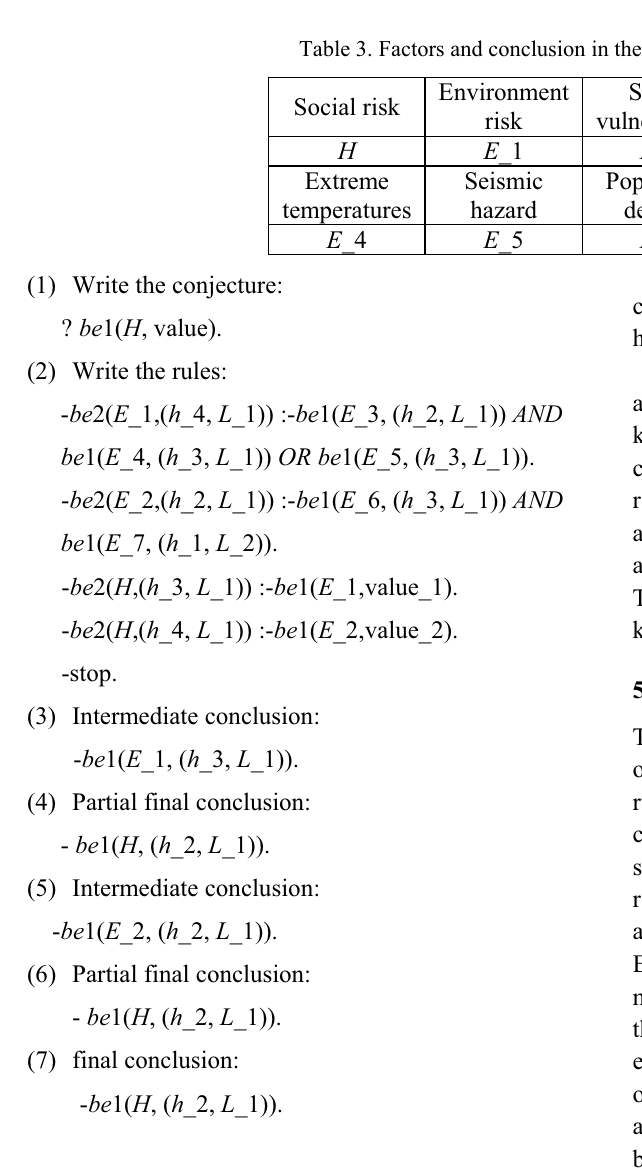
Fig. 3 A social risk assessment system